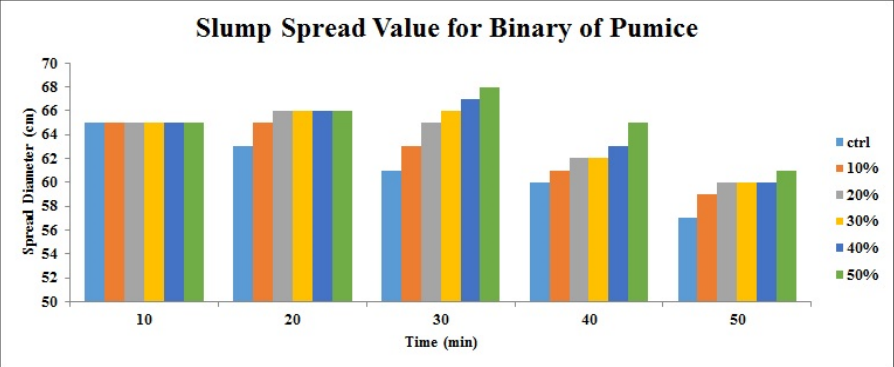
Figure 2. Slump value for pumice powder samples throughout the first 50 min.